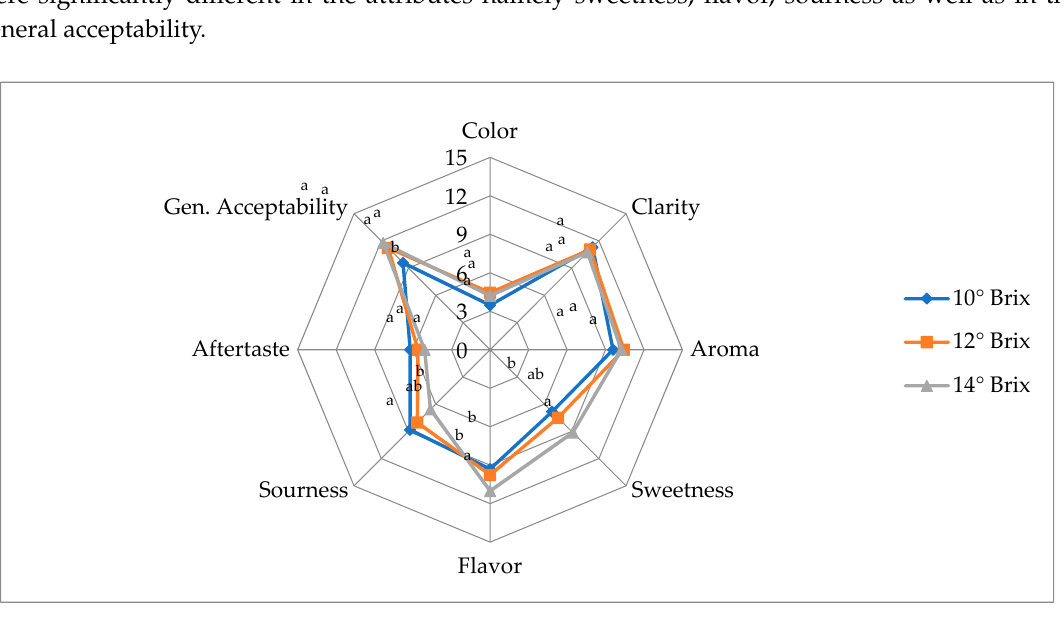
Figure 1. Plot comparing the intensities of the different sensory attributes of the formulated ready-to-drink ‘Saba’ banana juice evaluated using quality scoring.